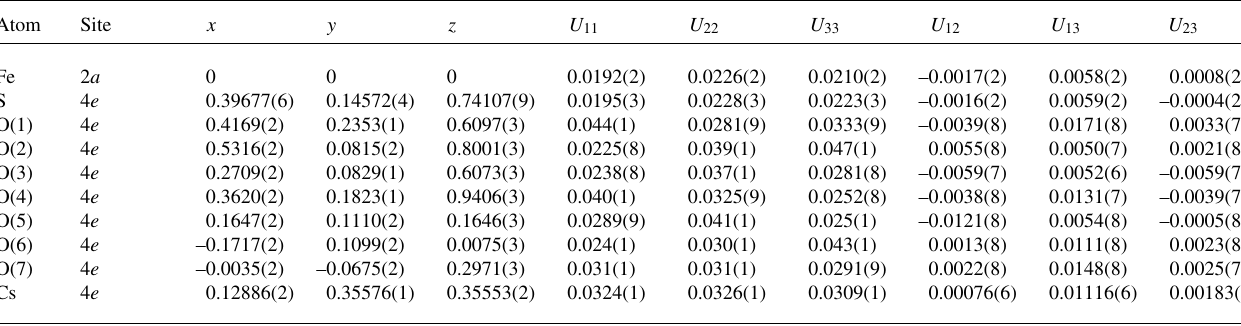
Table 9. Atomic coordinates and displacement parameters (in Å 2 ) .